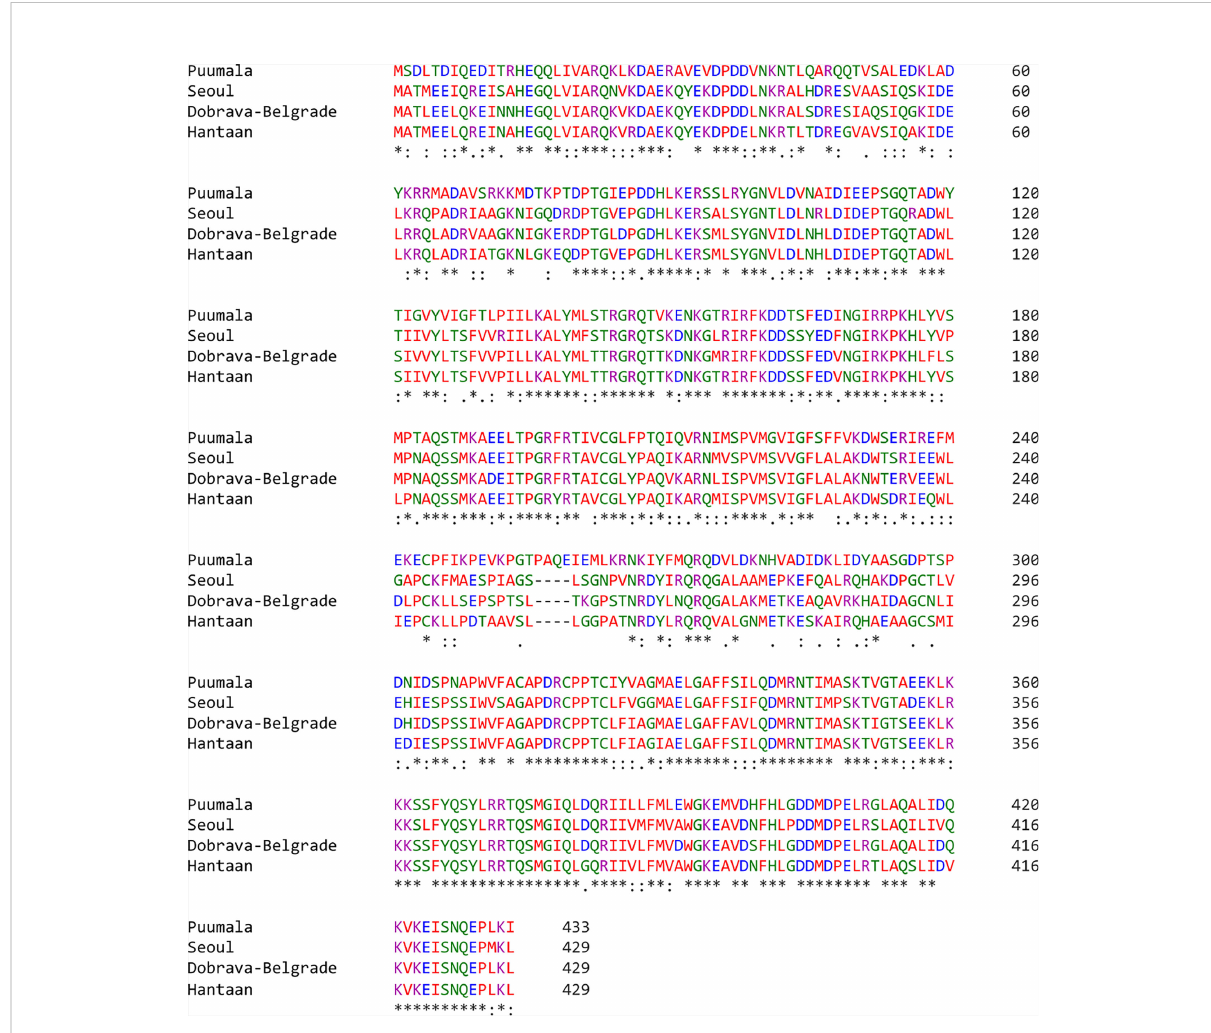
FIGURE 2 MSA of PUUV, SEOV, DOBV, and HTNV nucleoprotein sequences. Stars: amino acid sequence similarity; colons: amino acid sequence